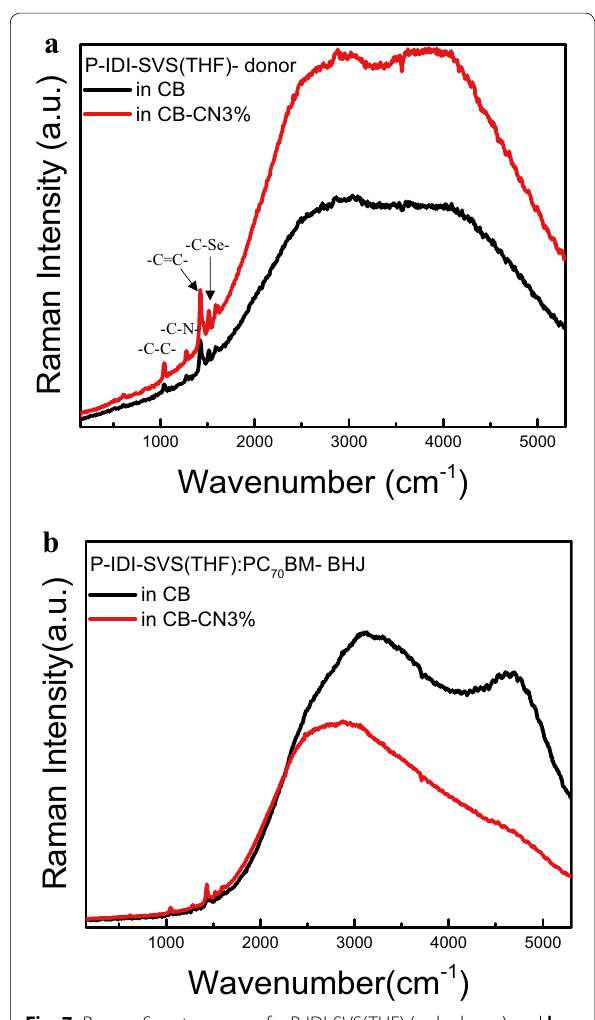
Fig. 7 Raman Spectroscopy of a P‑IDI‑SVS(THF) (only donor) and b P‑IDI‑SVS(THF):PC 70 BM (BHJ films) of donor only films with CB and CB–CN3%